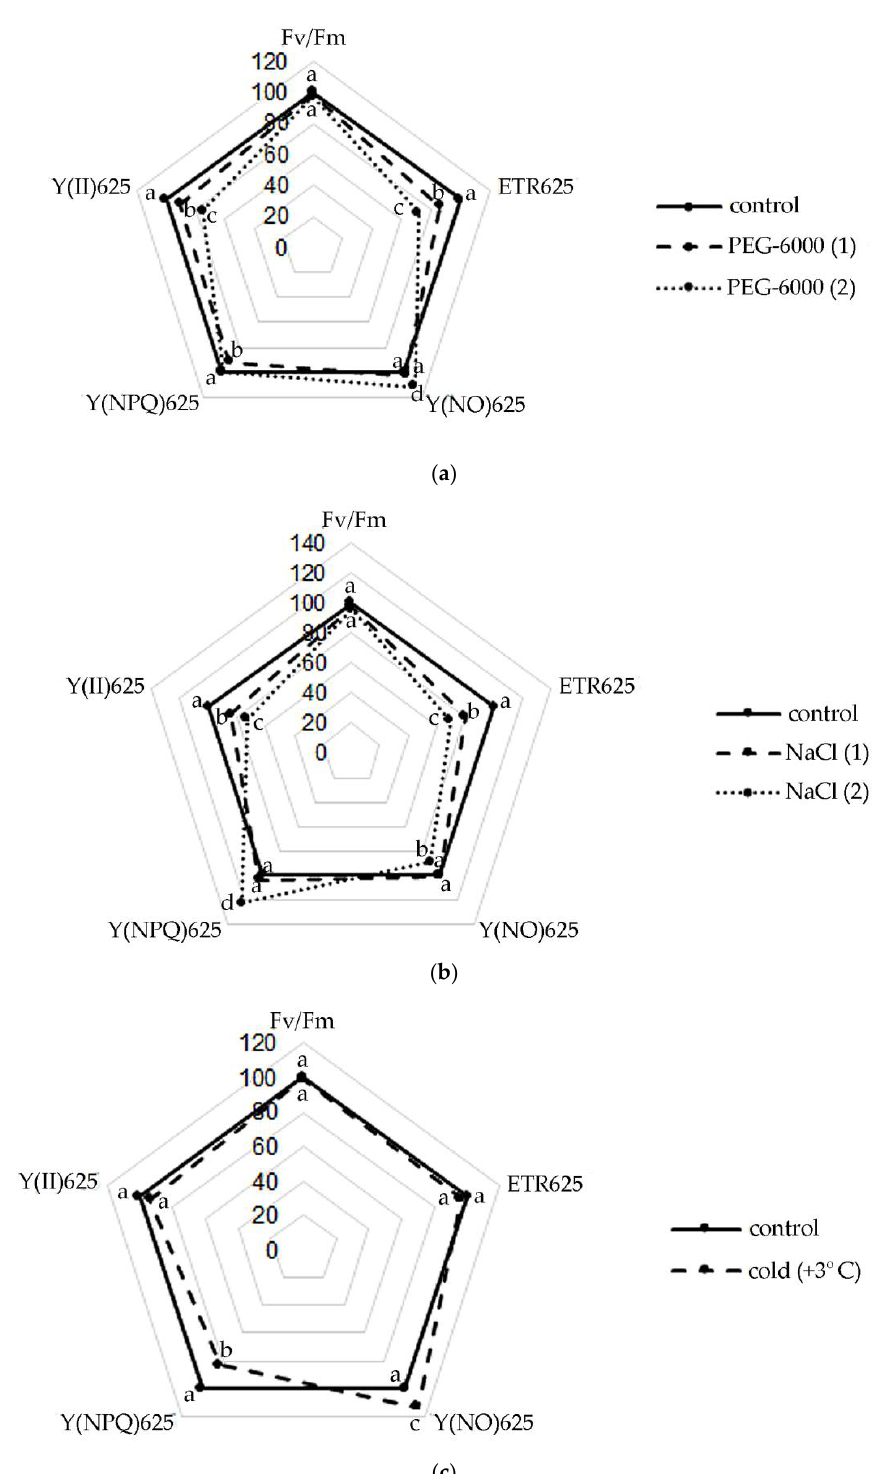
Figure 1. Changes in the activity of the photosynthetic apparatus of S. hybridum under stress conditions: ( a ) osmotic stress; ( b ) salt stress; ( c ) cold stress. Different letters above the peaks of the pentagram represent significant differences at p ≤ 0.05, n = 3 plants in each of 3 replicates for all treatments. It was also found that the rate of non-cyclic electron transport through PhS II (ETR) decreased in all variants of the experiment, except for the form of cold exposure. The decline in ETR values increased at the level of both osmotic and salt